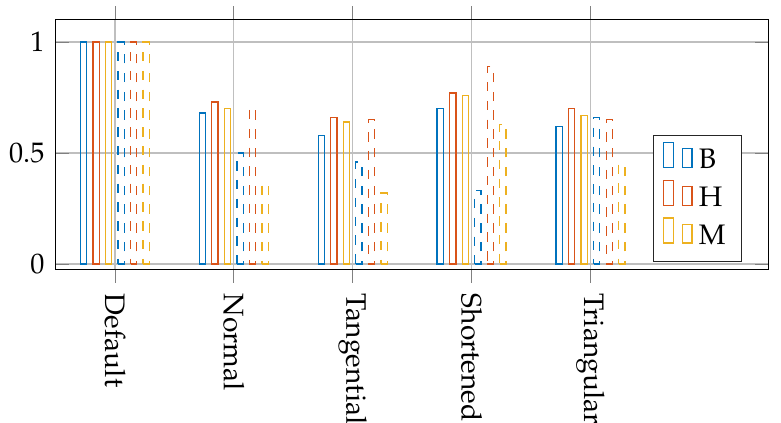
Figure 8. No-load fractional dependency of the inclination angles due to changed pole shoe design for the linear machine. Solid bars indicate the averaged fractional values and the dashed bars indicate the maximum fractional values, both also tabulated in Table 4.